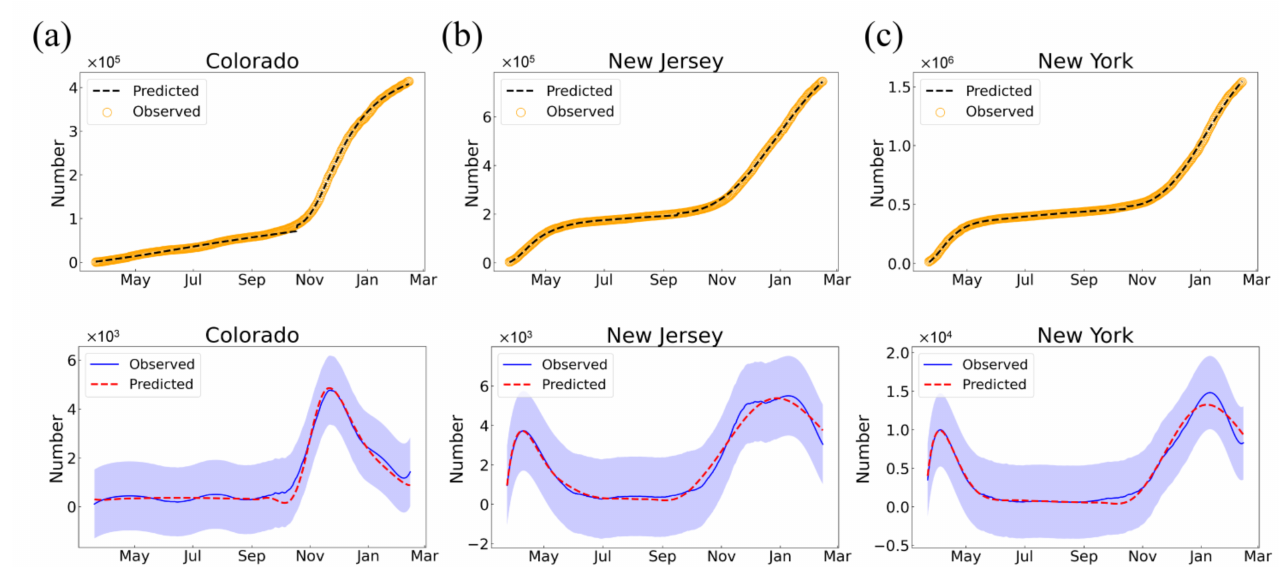
Figure 3. The fitting of our T-SIR model to the daily confirmed cases (upper row) and corresponding new cases (lower row) of COVID-19 for three selected states: Colorado ( a ), New Jersey ( b ), and New York ( c ) in the US that represent three categories of transmission dynamics in the US, where the dashed lines indicate the predicted data of T-SIR model. Data were smoothed using a Savitzky–Golay filter for daily new cases [46], where the light-blue shade indicates the standard deviations of reported